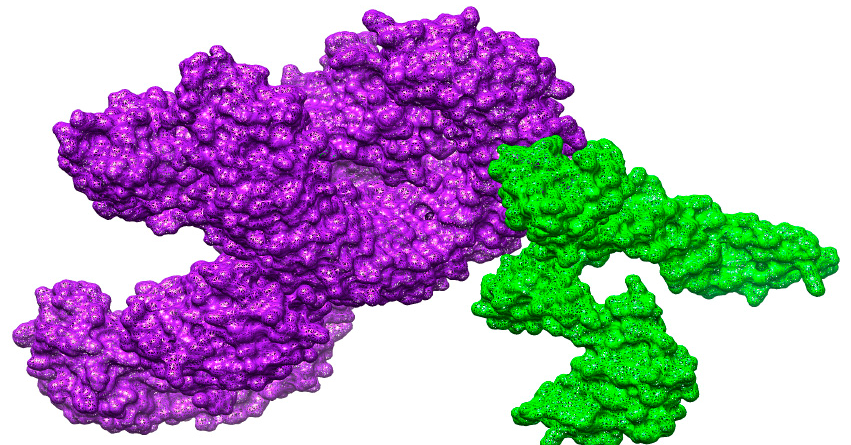
Figure 10. Docking of the vaccine to the MHC ‐ II molecule . The green color shows the vaccine mol ‐ ecule and pink represents MHC ‐ II.